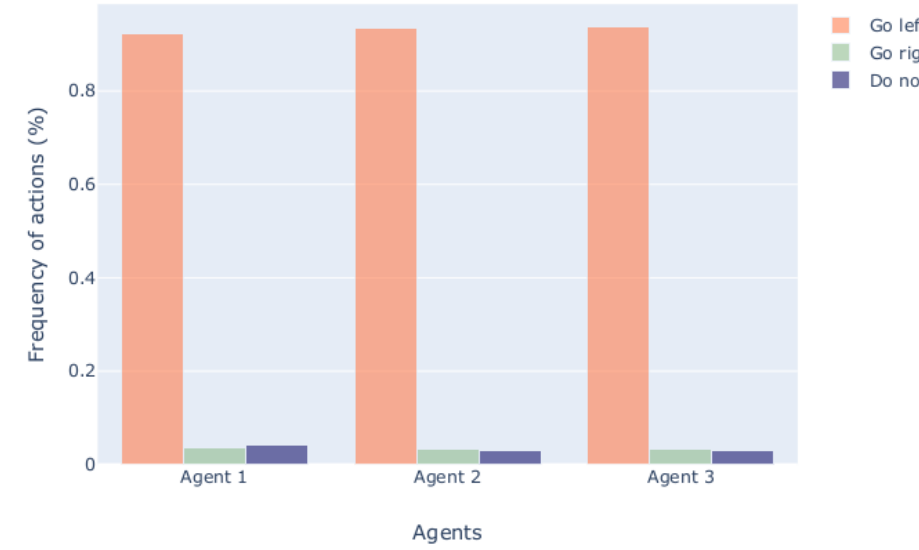
Figure 4. Frequency of actions for last 200 episodes of compound conflict with 3 agents.